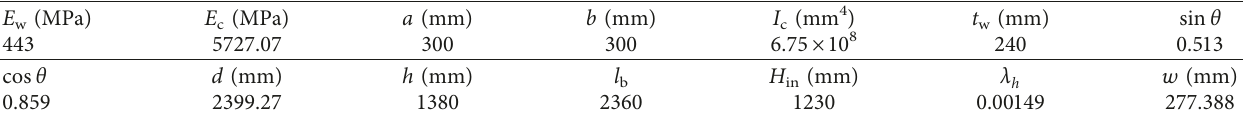
Figure 20: Optimization process of AFSA. Table 5: Parameters of improved equivalent diagonal strut model for